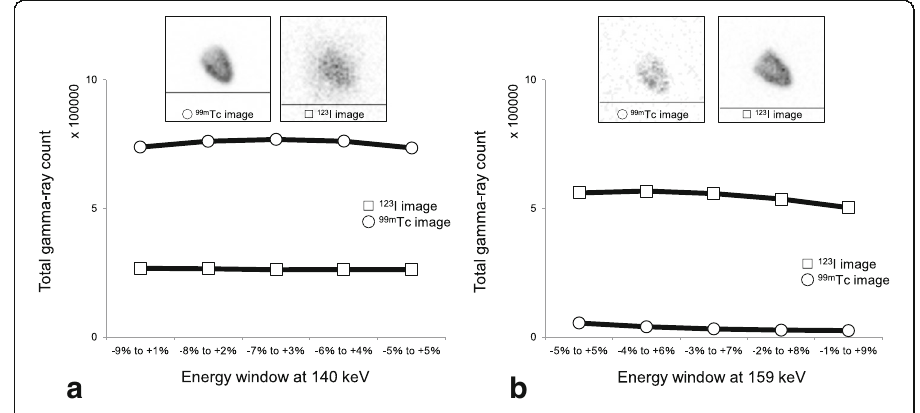
Fig. 3 Total gamma-ray counts of 99m Tc (white circles) and 123 I (white squares) in each energy window. Within 140 keV windows ( a ). Within 159 keV windows ( b )